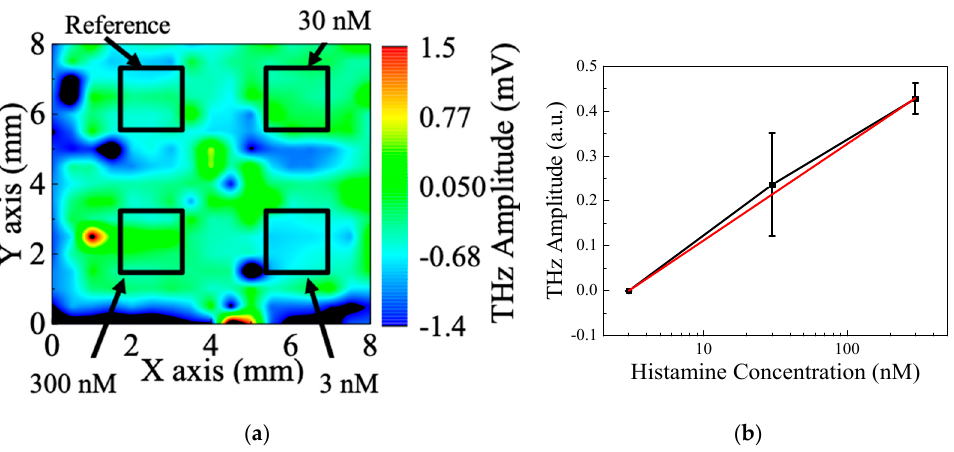
Figure 7. ( a ) Distribution of THz amplitude changes before and after histamine reaction. ( b ) THz amplitude changes versus three different concentrations of histamine.